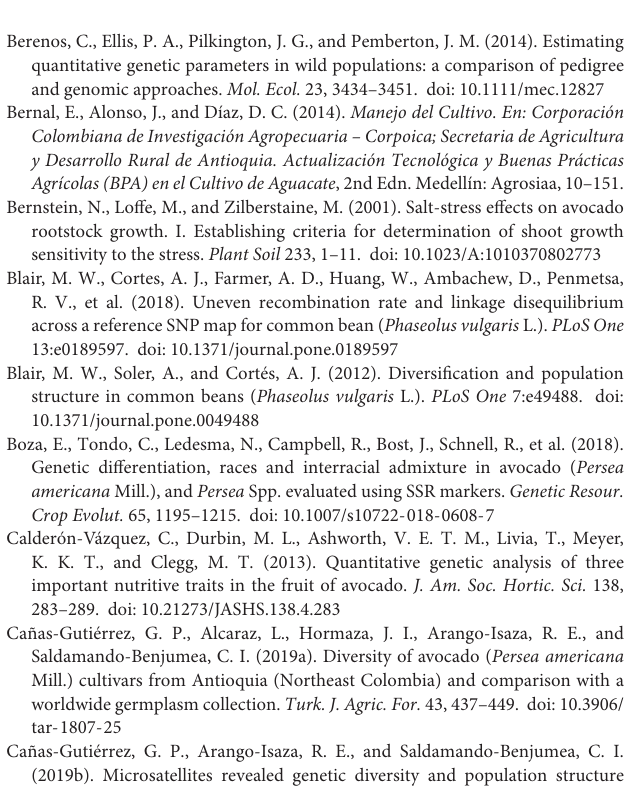
International Plant Genetic Resources Institute